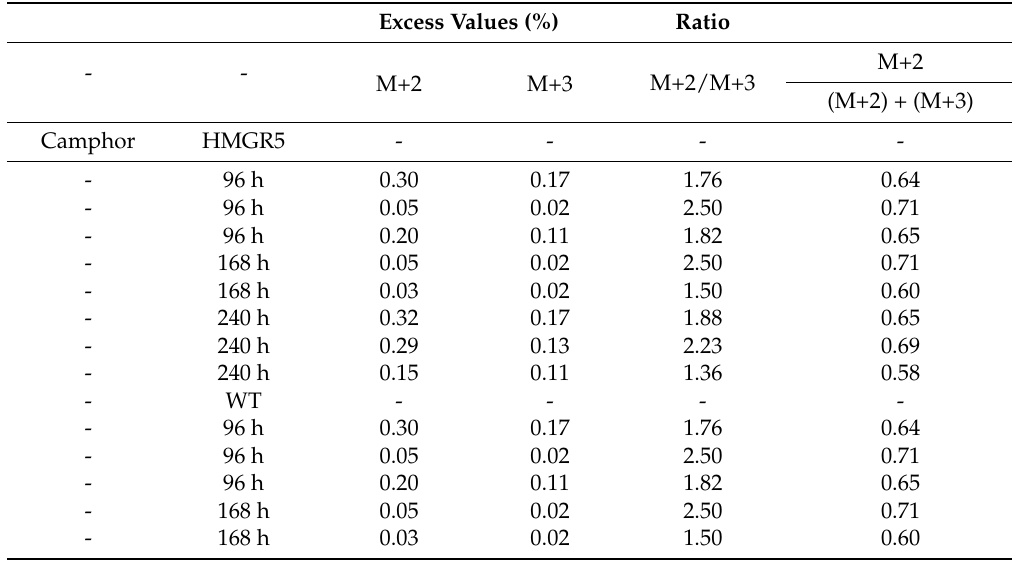
Table 6. GC/MS excess data for M+2 and M+3 isotopomeres in camphor extracted with chloroform-d and analyzed by GC/MS from spike lavender leaves from lines HMGR5 and WT at different points of time after the labelling pulse phase with 13 CO 2 . h: hours. 1 Excess Values (%)